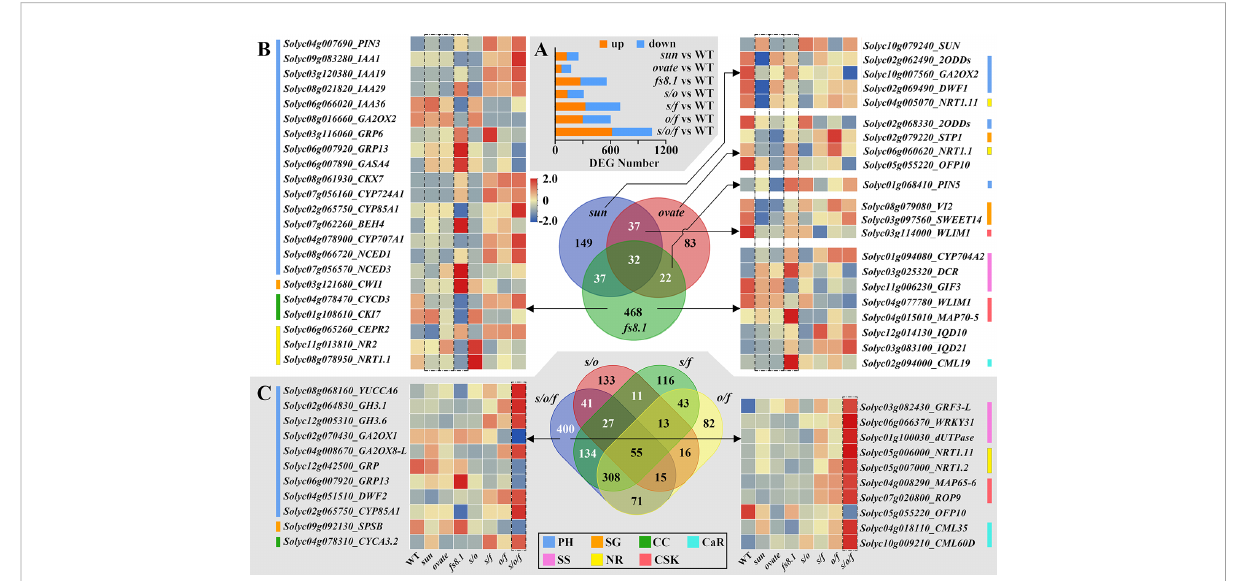
FIGURE 5 Number of DEGs and Venn diagram analyses of transcriptomes of seeds in fruit shape NILs. (A) Differentially expressed genes (DEGs) number at 8 dpa. (B) Venn diagram of sun , ovate and fs8.1 NILs. (C) Venn diagram of double and triple NILs. PH, plant hormone-related genes; SG, suger- related genes; CC, cyclin; CaR, calcium-related genes; SS, seed size-related genes; NR, nitrate-related genes; CSK, cytoskeleton-related